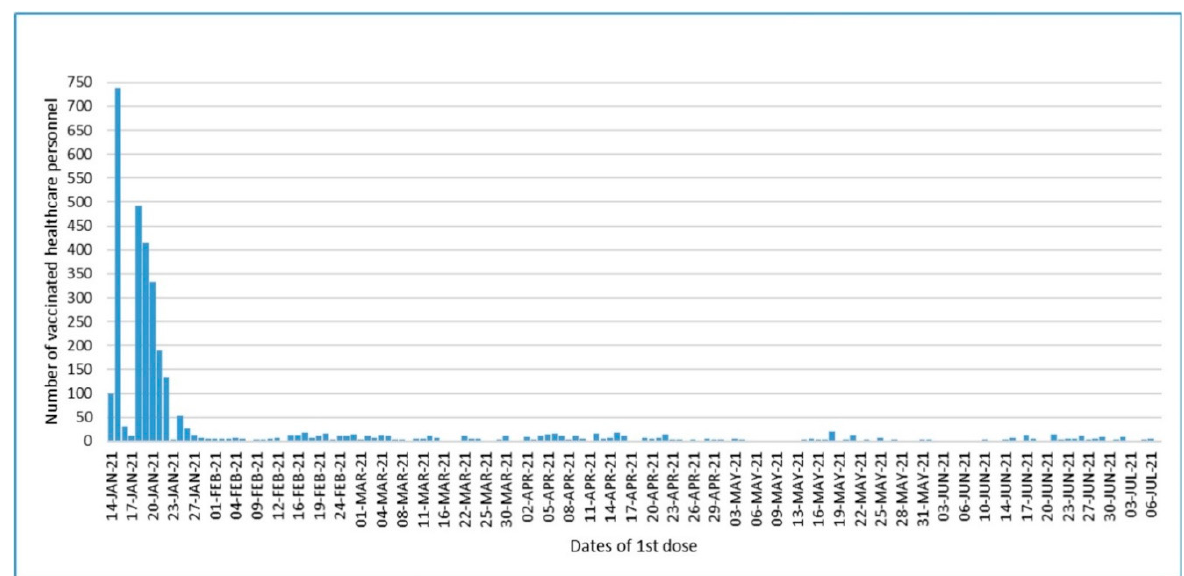
Figure 2. Dates of first vaccine dose in the vaccinated personnel. Table 2. Comparisons of vaccinated and unvaccinated healthcare personnel according to the survey. Characteristics